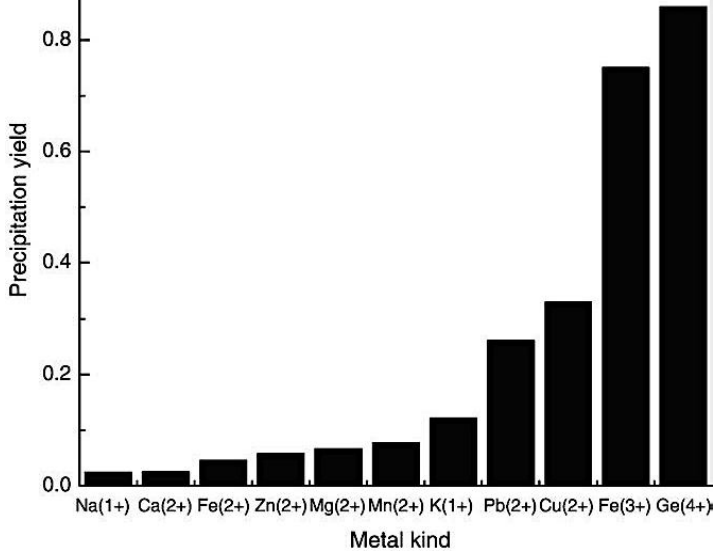
Figure 8. Binding ability of various metals in a single metal solution with tannins